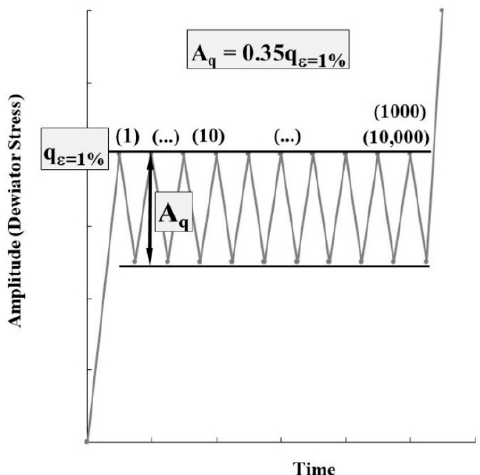
Figure 3. Cyclic load scheme at constant deviator stress amplitude A q .